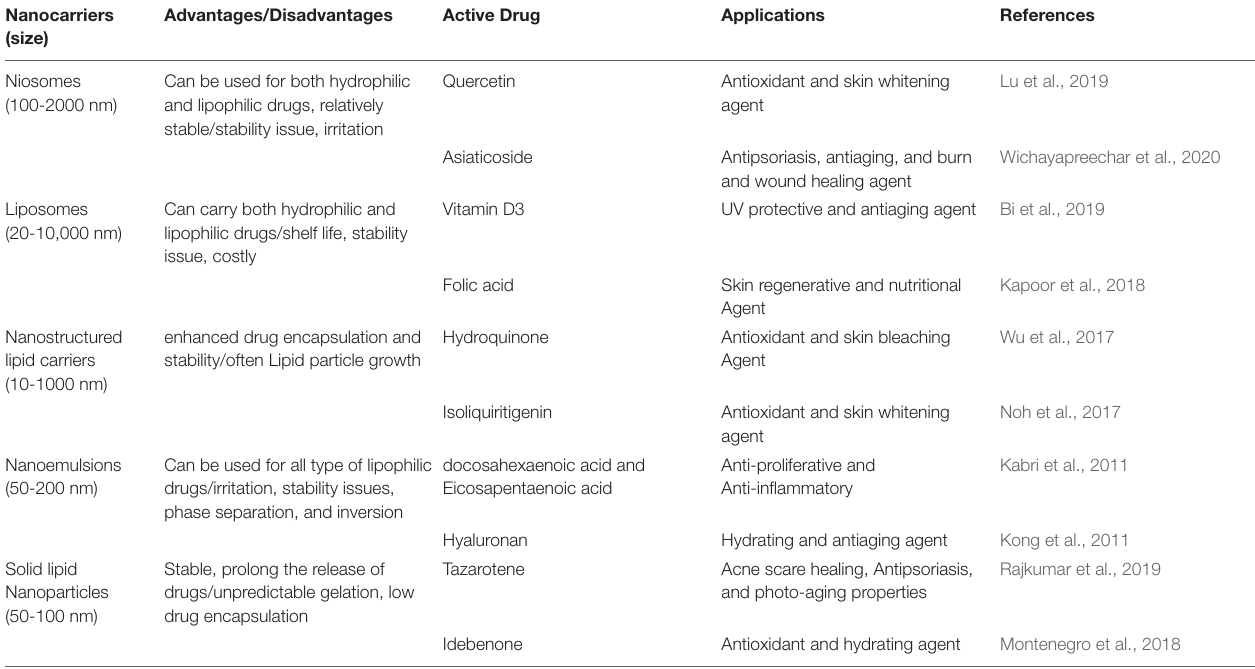
TABLE 2 | Therapeutic materials encapsulated in nanocarriers and their applications.